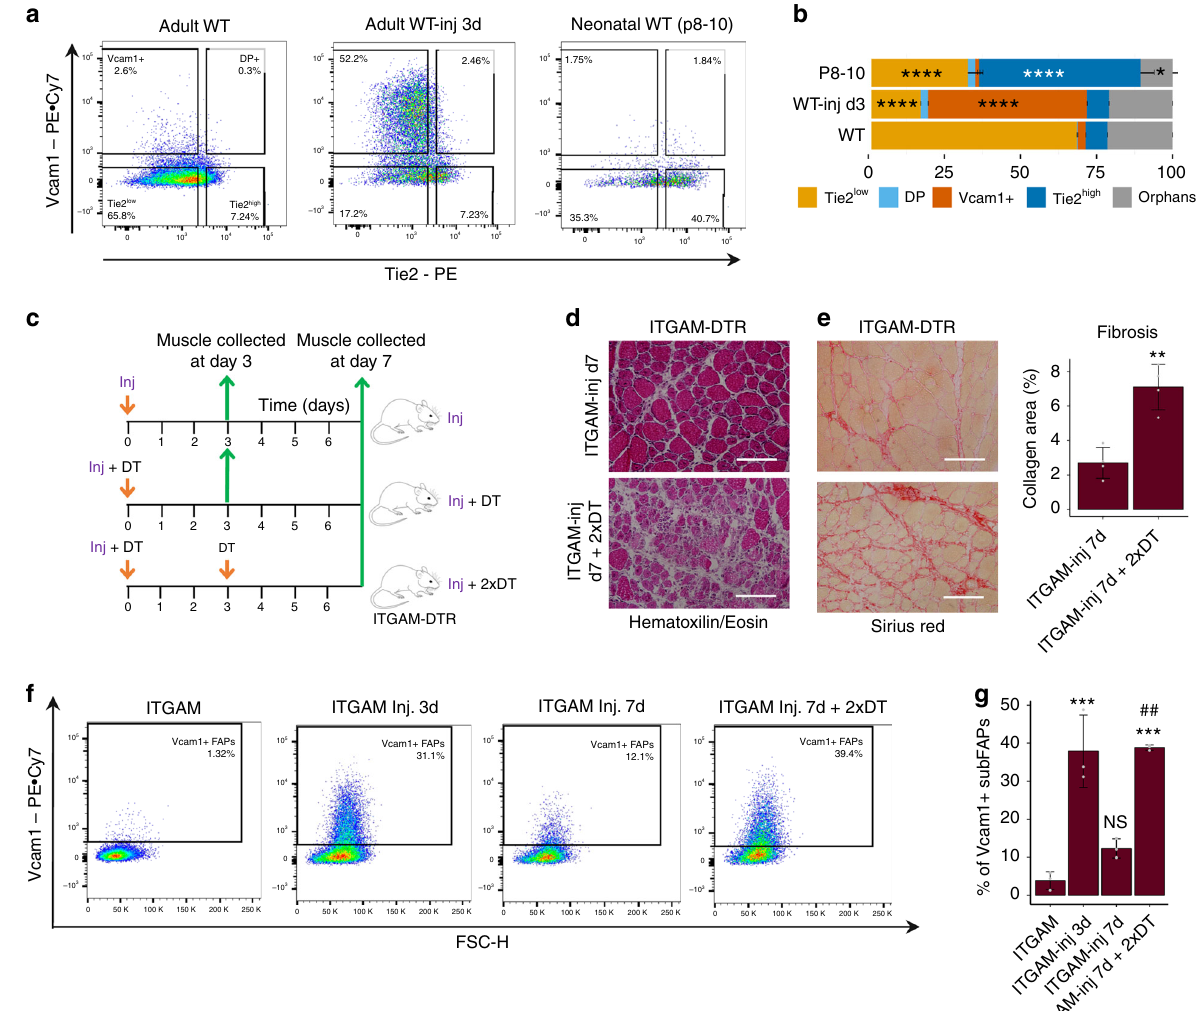
Fig. 4 SubFAPs are distinctly associated with neonatal and injury-induced myogenesis. a Representative FACS plots of FAPs analyzed based on Tie2 and Vcam1 expression in adult wild type (WT), adult WT notexin-injured day 3 (WT-inj d3) and neonatal WT C57Bl/6J mice (postnatal day 8 – 10). FAPs were isolated from hindlimb muscles. b Distribution of subpopulations in each experimental condition by FACS analysis (mean + s.e.m., n = 6 (three independent experiments, each including biological duplicates), * P < 0.05, **** P < 0.0001). Statistical signi fi cance was determined by one-way ANOVA with Bonferroni post hoc test, and comparisons to the WT control group are reported. c Experimental design of the macrophage depletion study. ITGAM- DTR mice were used for this study. Acute muscle injury (Inj) was induced with either NTX (10 µ l of 10 µ g/ml notexin) or CTX (10 μ l of 10 μ M cardiotoxin). Macrophage depletion was achieved with diphtheria toxin (DT) injection (12 ng/g) at the time points indicated. Muscles were collected at day 0, 3 or 7 after injury. d , e Hematoxylin/Eosin ( d ) and Sirius Red ( e -left panel) stainings of gastrocnemius muscle sections 7 days after an acute injury (ITGAM-inj d7) and 7 days after an acute injury in the context of macrophage depletion (ITGAM-inj d7 + 2xDT). Quanti fi cation of fi brosis in muscle sections stained with Sirius Red ( e -right panel; n = 4, mean + s.d., t -test, ** P < 0.01). Scale bar 200 µ m. f Representative FACS plots pro fi les of Vcam1 + cells within FAPs population. g Percentage of Vcam1 + FAPs in the conditions analyzed in f . Statistical signi fi cance was determined by one-way ANOVA with Bonferroni post hoc test, and only comparisons to the control ITGAM (*) and to ITGAM-Inj. 7d (#) groups are reported (mean + s.d., n = 3 independent experiments, ANOVA, *** P < 0.001, ## P <